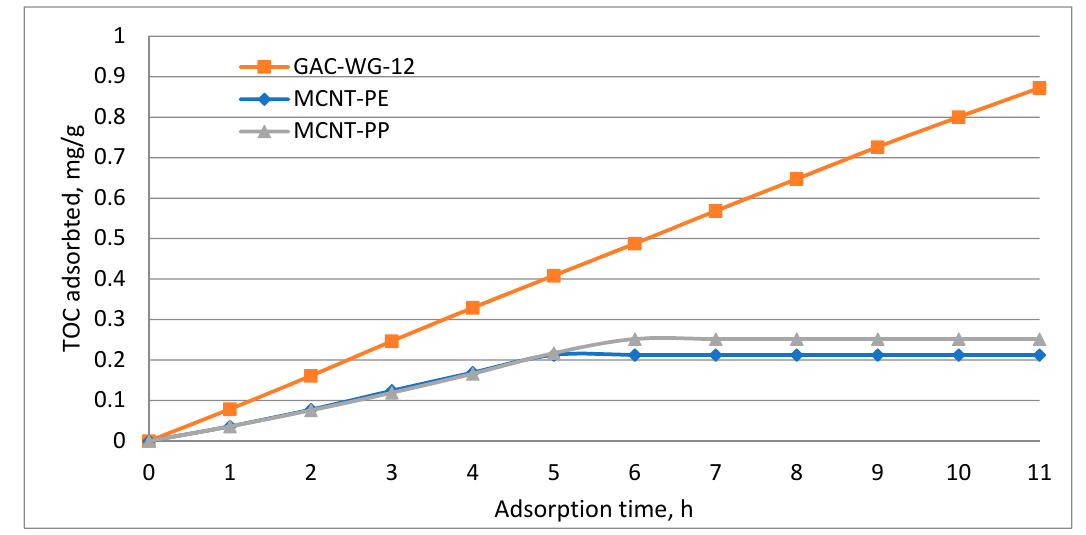
Figure 6. Amount of retained organic substances per 1 g of sorbents.